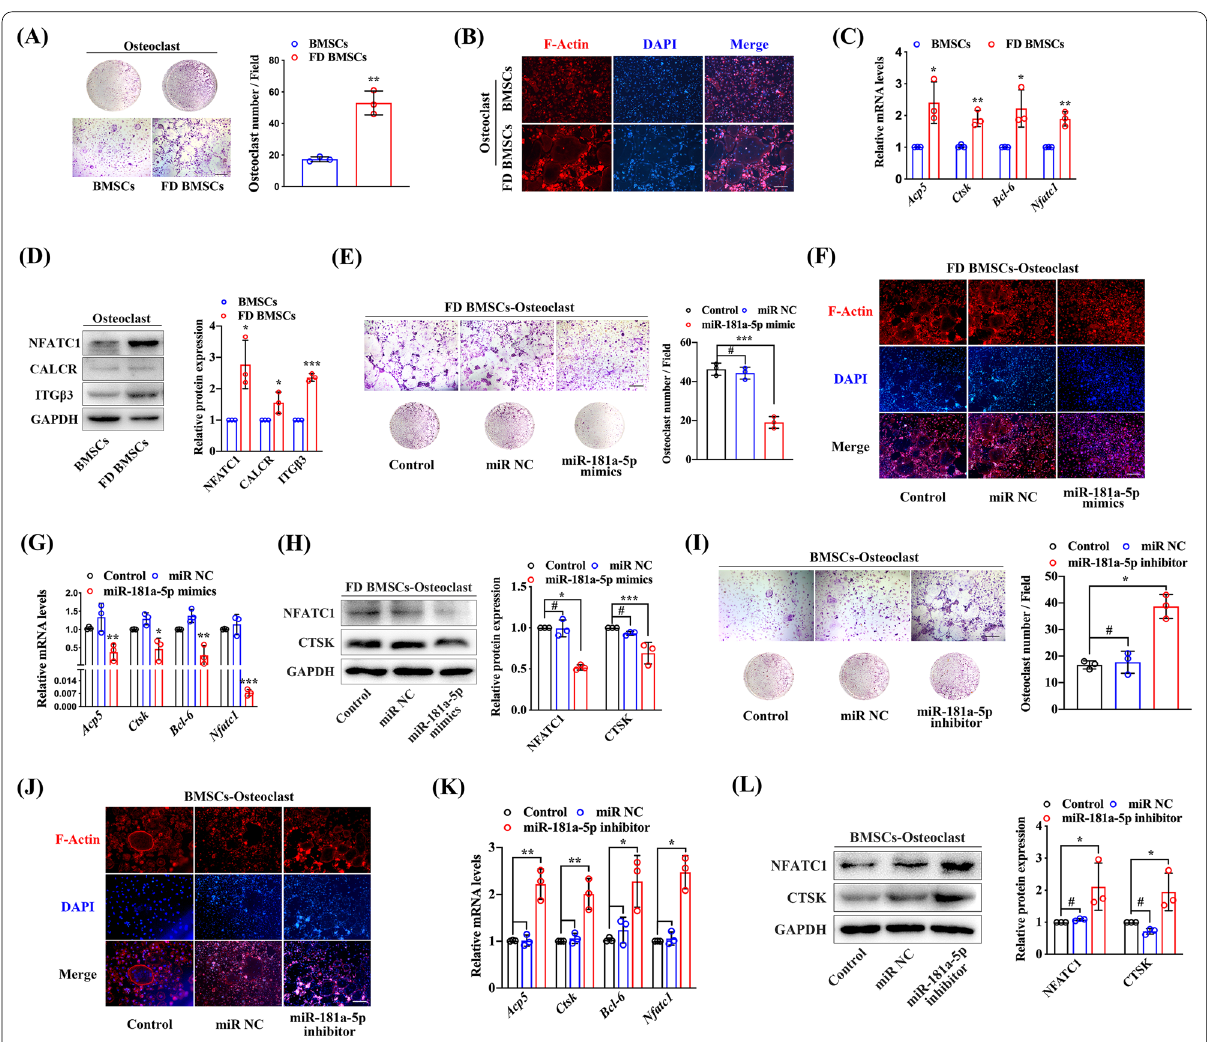
Fig. 4 Low miR-181a-5p expression promotes FD BMSC-induced osteoclast differentiation and formation. a BMSC- and FD BMSC-induced osteoclast differentiation was analyzed by TRAP staining. b Representative image of the F-Actin ring structure in osteoclasts. Osteoclast differentiation-related gene expression was detected by quantitative real-time PCR ( c ) and western blot ( d ). e Effect of miR-181a-5p mimics on FD BMSC-induced osteoclast differentiation was analyzed by TRAP staining. f Representative image of the F-Actin ring structure in osteoclasts under miR-181a-5p mimics treatment. Osteoclast differentiation-related gene expression was detected by quantitative real-time PCR ( g ) and western blot ( h ) in osteoclasts induced by FD BMSCs transfected with miR-181a-5p mimics. i Effect of the miR-181a-5p inhibitor on BMSC-induced osteoclast differentiation was analyzed by TRAP staining. j Representative image of the F-Actin ring structure in osteoclasts under miR-181a-5p mimics treatment. Osteoclast differentiation-related gene expression was detected by quantitative real-time PCR ( k ) and western blot analysis ( l ) in osteoclasts induced by BMSCs transfected with miR-181a-5p inhibitor. Scale bar, 100 μm. The data are presented as the mean # P > 0.05; * P < 0.05; ** P < 0.01; *** P <